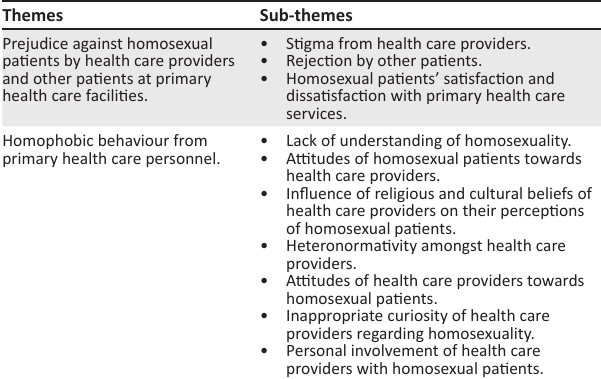
TABLE 1: Themes and